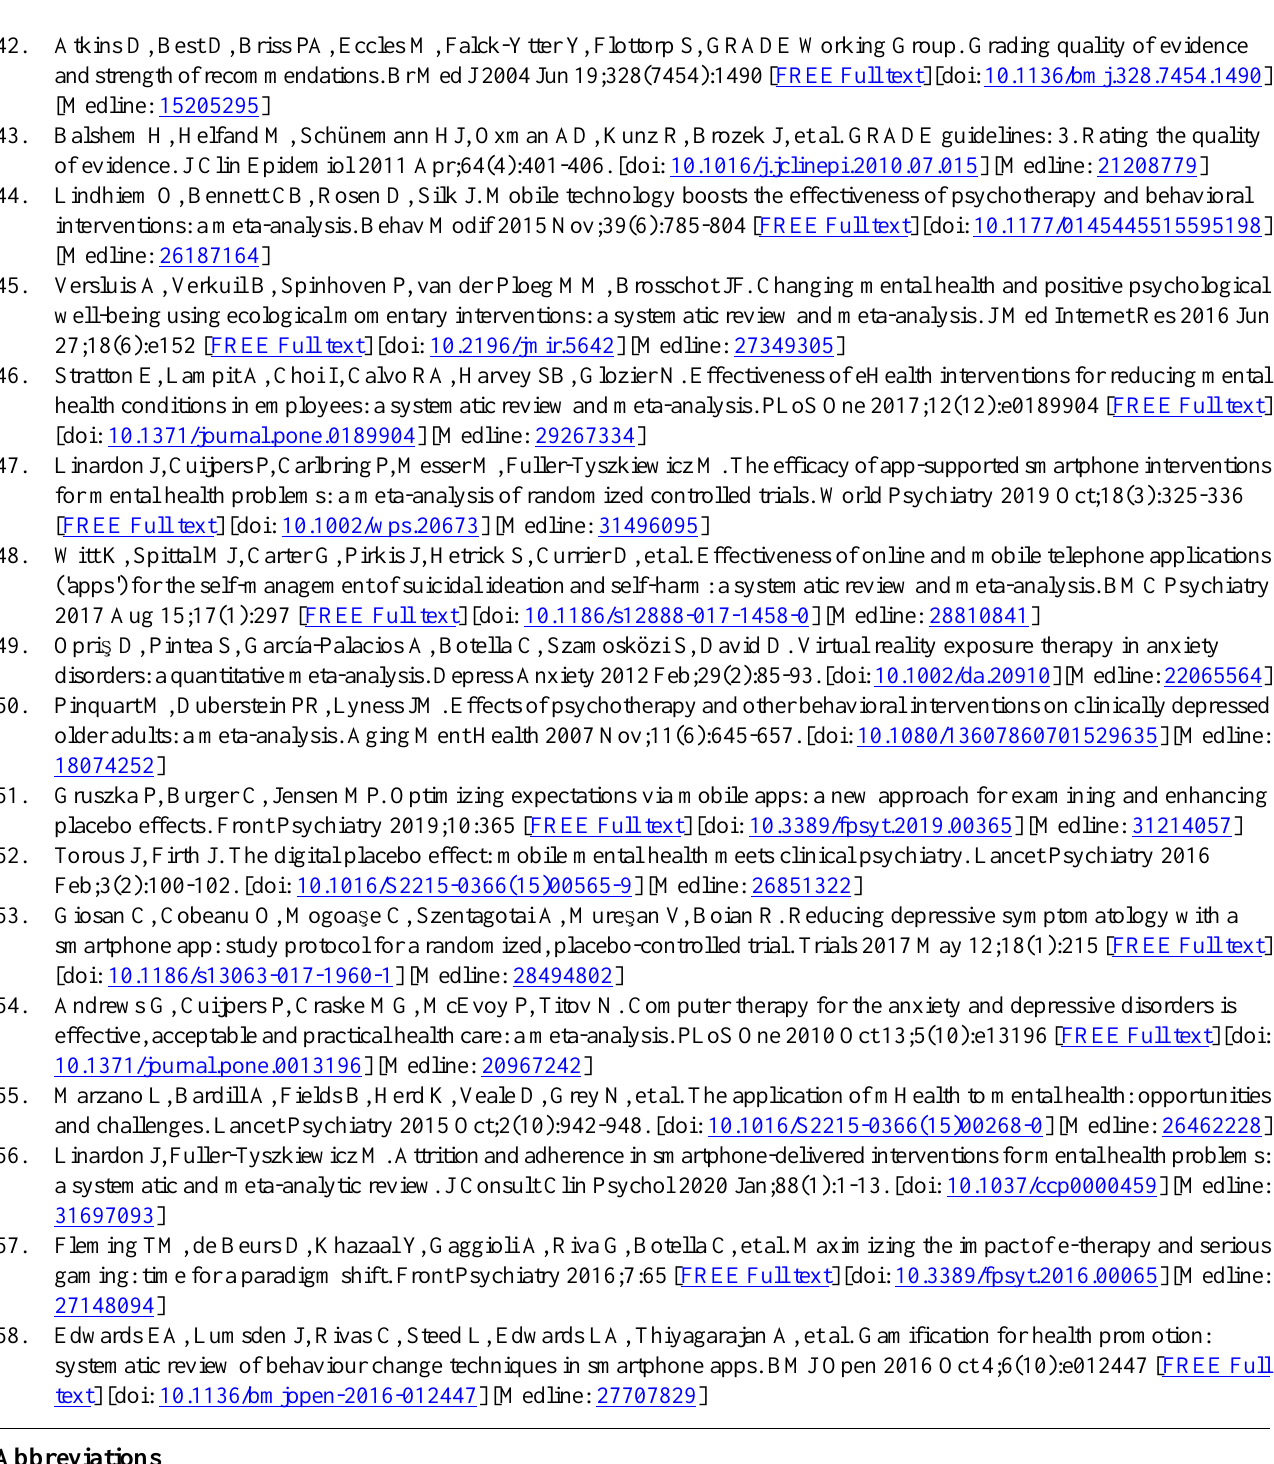
EMI: Ecological Momentary Interventions GRADE: grading of recommendations, assessment, development, and evaluation mHealth: mobile